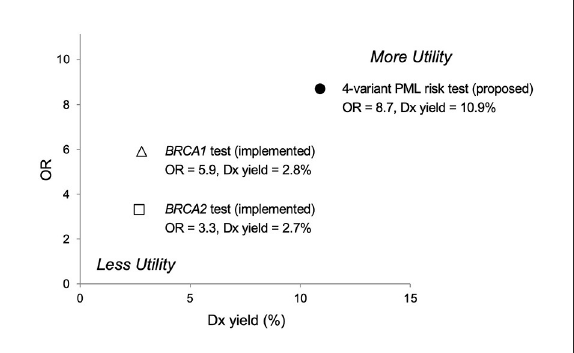
FIGURE2 Predictive risk comparison to BRCA screening tests, odds ratio (OR) vs. diagnostic (Dx) yield. Results for a 4-variant PML risk test are shown in comparison to the BRCA1 / BRCA2 breast cancer risk prediction test. The proposed 4-variant PML risk test data point ( (cid:8) ) is based on the total drug-exposed PML cases (Table 5). The BRCA1 ( 1 ) and BRCA2 ( (cid:3) ) risk test data points are based on results for over 95,000 women reported in Kurian et al. (53). More Utility is defined as higher OR and higher Dx yield and Less Utility is defined as lower OR and lower Dx